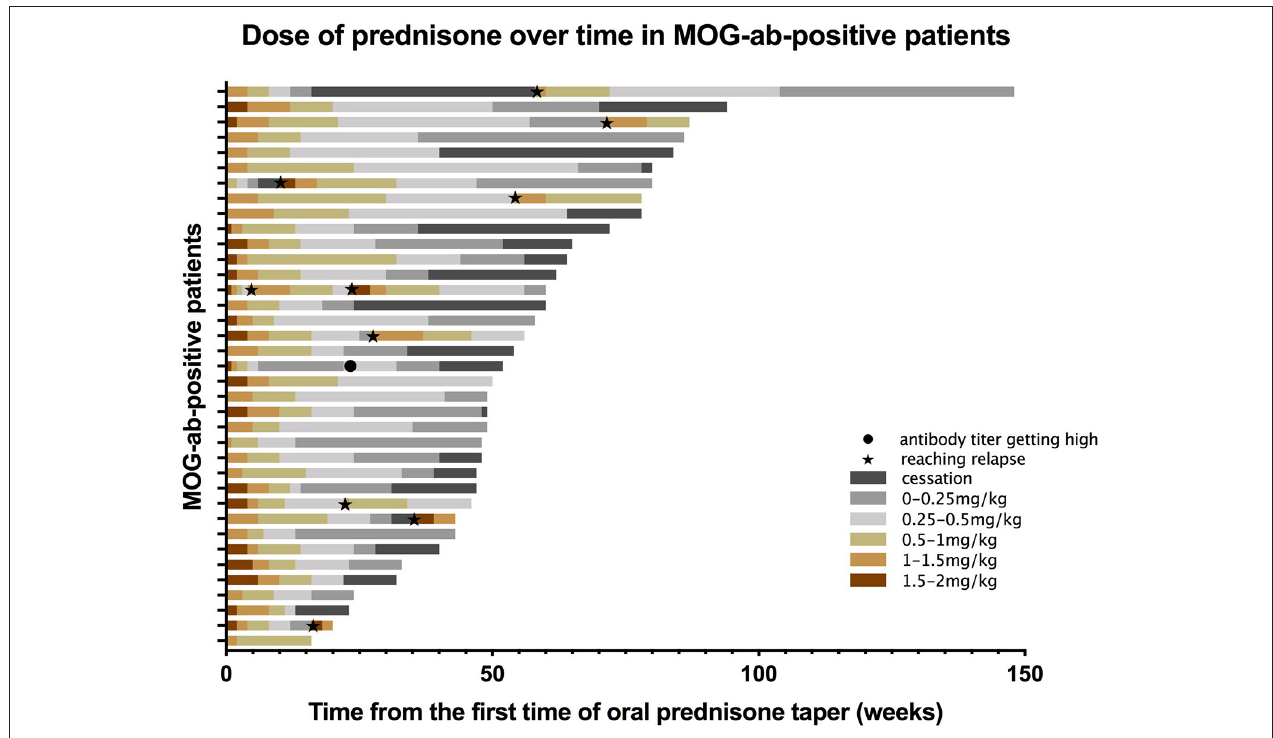
FIGURE 3 | Prednisone taper dose over time in MOG-ab-positive patients. Each bar represents an individual participant. Different colors represent different doses of prednisone. For example, reddish-brown bars indicate the taper for 1.5–2 mg/kg per day. The black dot indicates a sudden high titer of MOG-ab in a patient, and black pentagrams indicate patients reaching relapse.